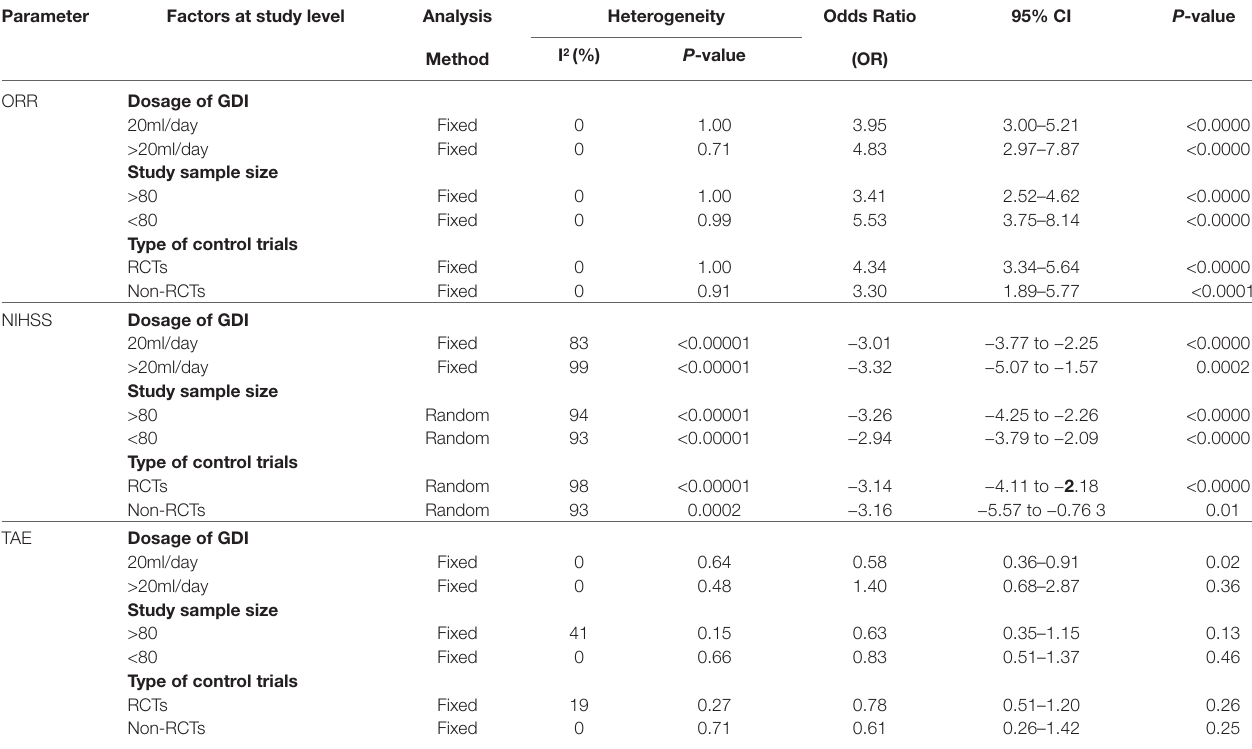
tABLE 2 | Subgroup analyses of ORR, NIHSS and TAE between the experimental and control group.